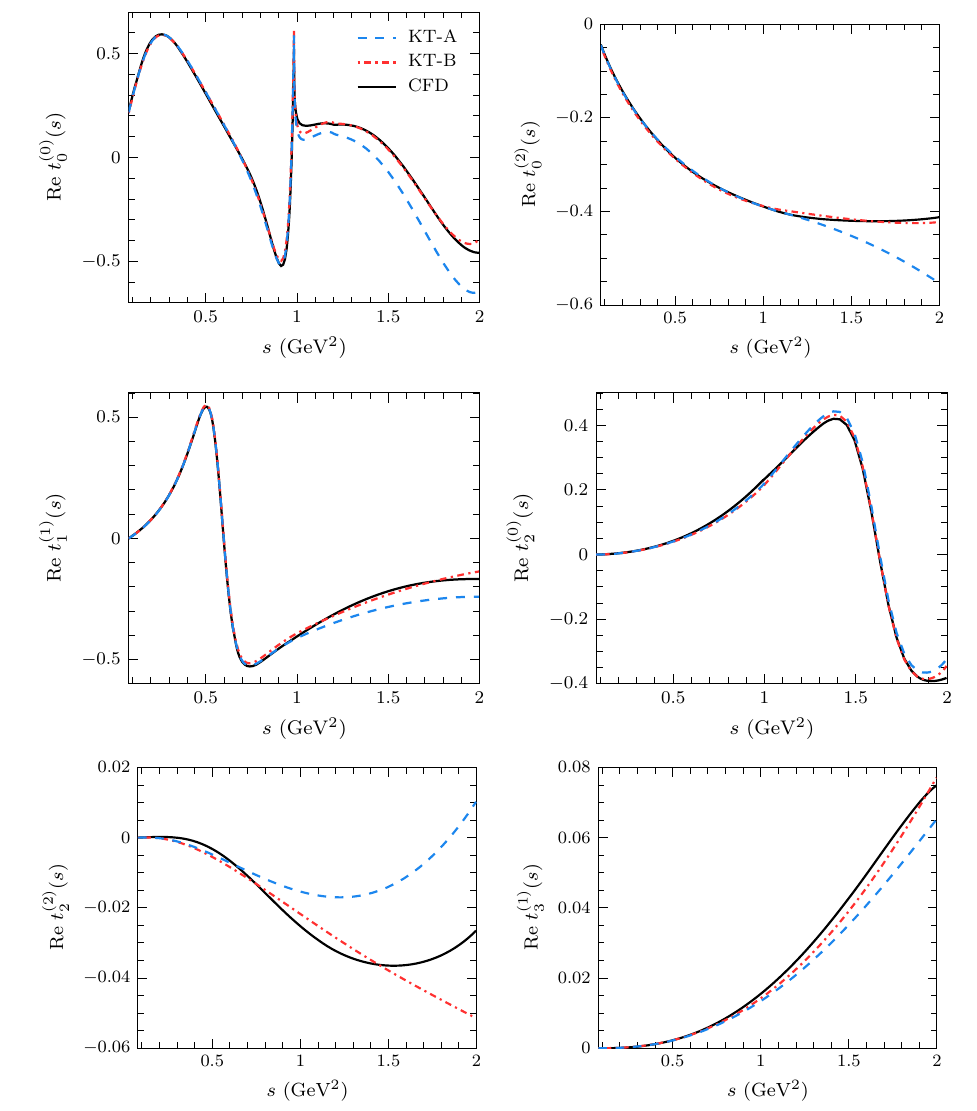
Fig. 1 Comparison of the real part of the different input partial-wave ( I ) ( s ) taken from Ref. [40] (black lines, labeled as amplitudes ( t CFD ) (cid:6) ( I ) ( s ) . The two setups A (blue dashed line) and B (red CFD) with ( t KT ) (cid:6)